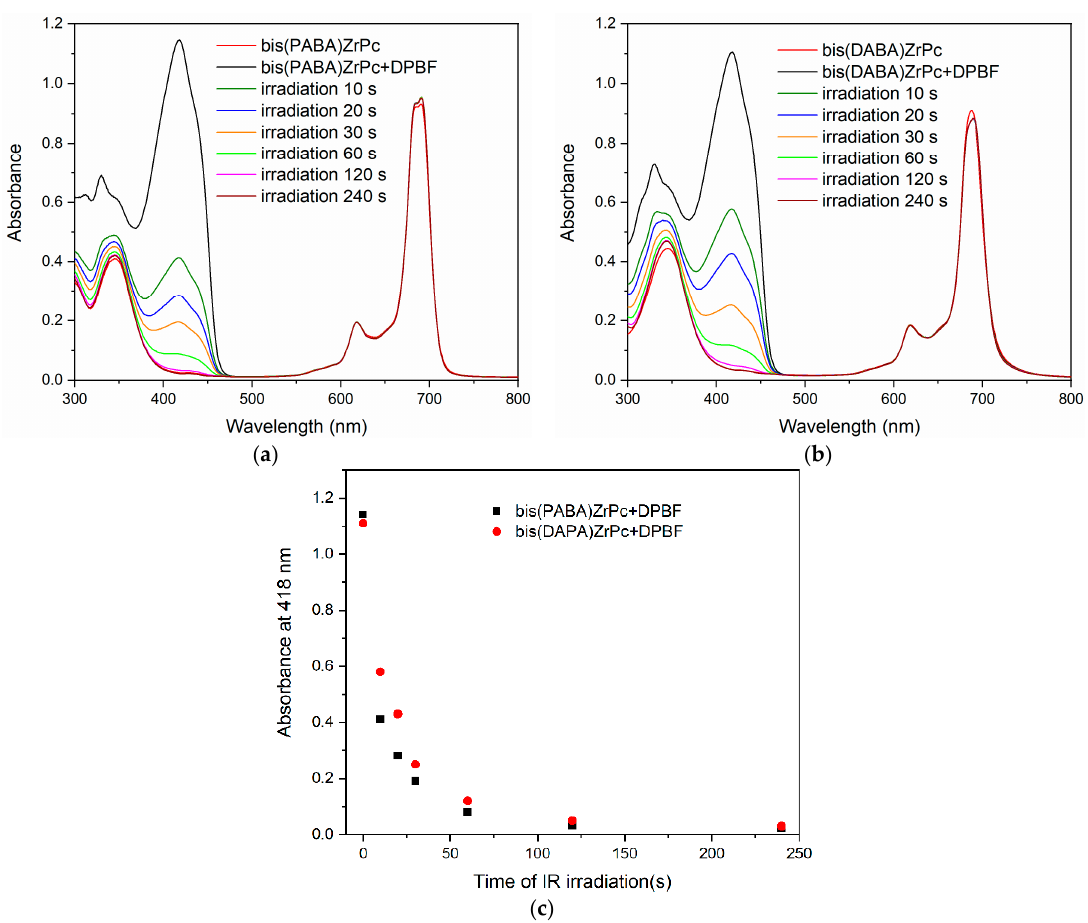
Figure 7. Absorption spectra of ( a ) bis (PABA) ZrPc and ( b ) bis (DABA) ZrPc solutions in DMSO before and after addition of 1,3-diphenylisobenzofuran showing DPBF bleaching when exposed to light irradiation (due to singlet oxygen generation). ( c ) Irradiation time dependence of DPBF absorbance in the presence of ZrPcs.